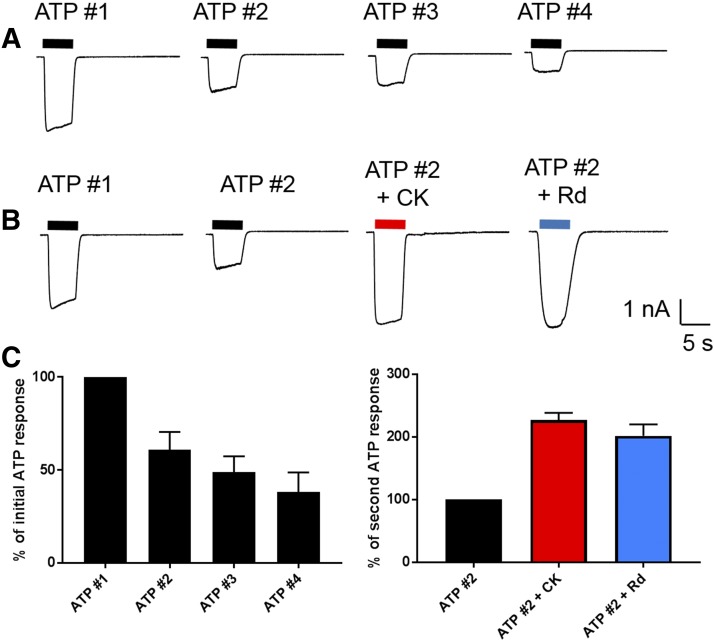
Patch clamp analysis confirms CK, and Rd enhances ATP-induced currents. HEK-hP2X4 cells were voltage clamped at −60 mV, and (A) ATP (5 µM) was rapidly applied for 5 seconds (pulse denoted by black bars), followed by a 45-second washout with standard extracellular solution. In control cells, further applications of ATP were applied every 1 minute for a total of four applications. Human P2X4 responses were observed to display consistent rundown. (B) In ginsenoside-treated cells, an initial control application of ATP was administered and then the second application was ATP plus CK or ATP plus Rd (both at 10 µM). (C) Normalized current amplitudes (pA/pF) showing ATP rundown over the first four applications. Potentiation of ATP responses by CK (red) and Rd (blue) expressed as percentage of second ATP response.